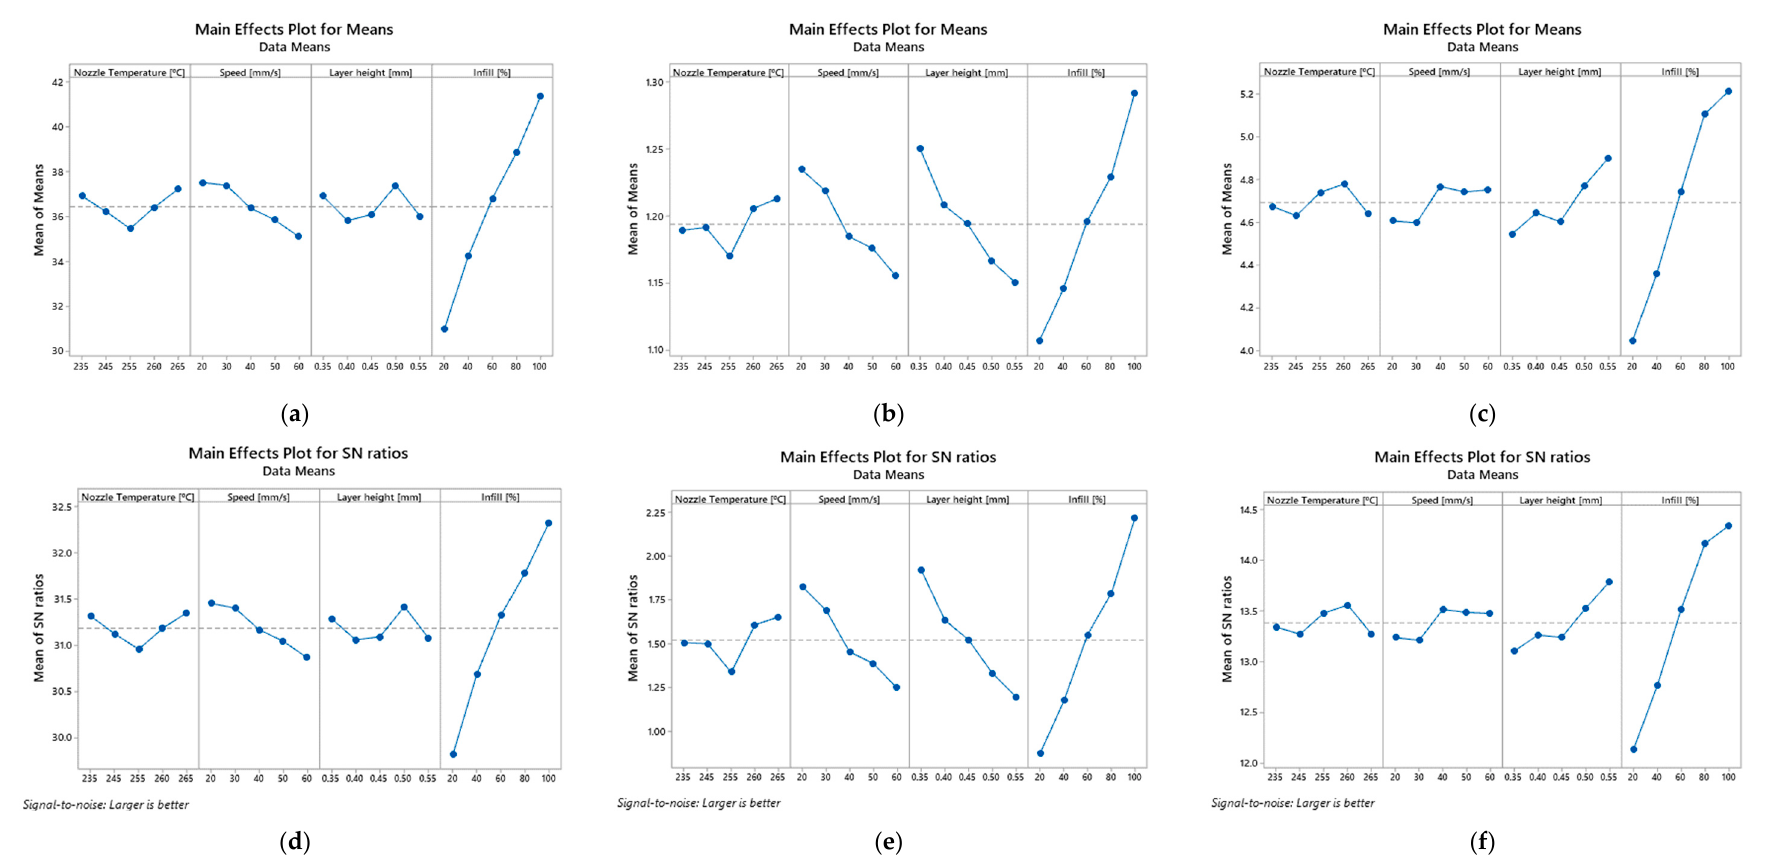
Figure 5. Main effect plot for means of: ( a ) bending stress, ( b ) bending modulus, ( c ) bending strain, and main effect plot for means of S/N ratios of: ( d ) bending stress, ( e ) bending modulus, ( f ) bending strain for PETG+KF samples.